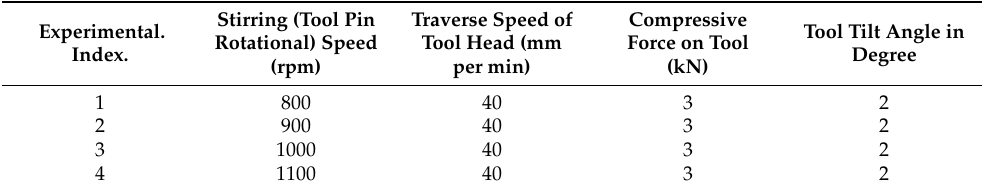
Table 2. Description of theprocess parameters used for FSP.